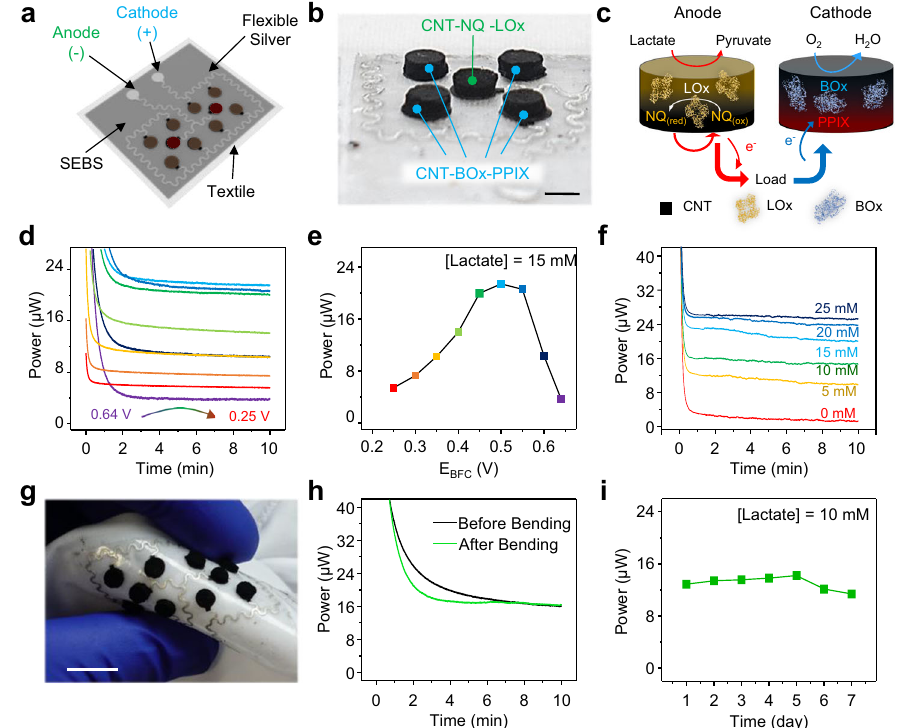
Fig. 3 Characterization of the performance of the BFC module. a Schematic image of the textile-based BFC module composed of eight BOx-based cathodes and two LOx-based anodes connected by printed fl exible interconnections. b A zoomed-in photo image of the fabricated BFC module. Scale bar, 5 mm. c The charge generation mechanism of the BFC from lactate and oxygen in sweats. d The output power of the BFC module at different discharge potentials with 15 mM lactate concentration. e The equivalent polarization curve derived from (d). f The output power of the BFC module discharged at 0.5 V under various lactate concentrations. g Image of the BFC module under 180° outward bending. Scale bar, 1 cm. h The power of the BFC module before and after the 1000 bending cycles. i The output power of the BFC module with 10 mM lactate concentration everyday within a